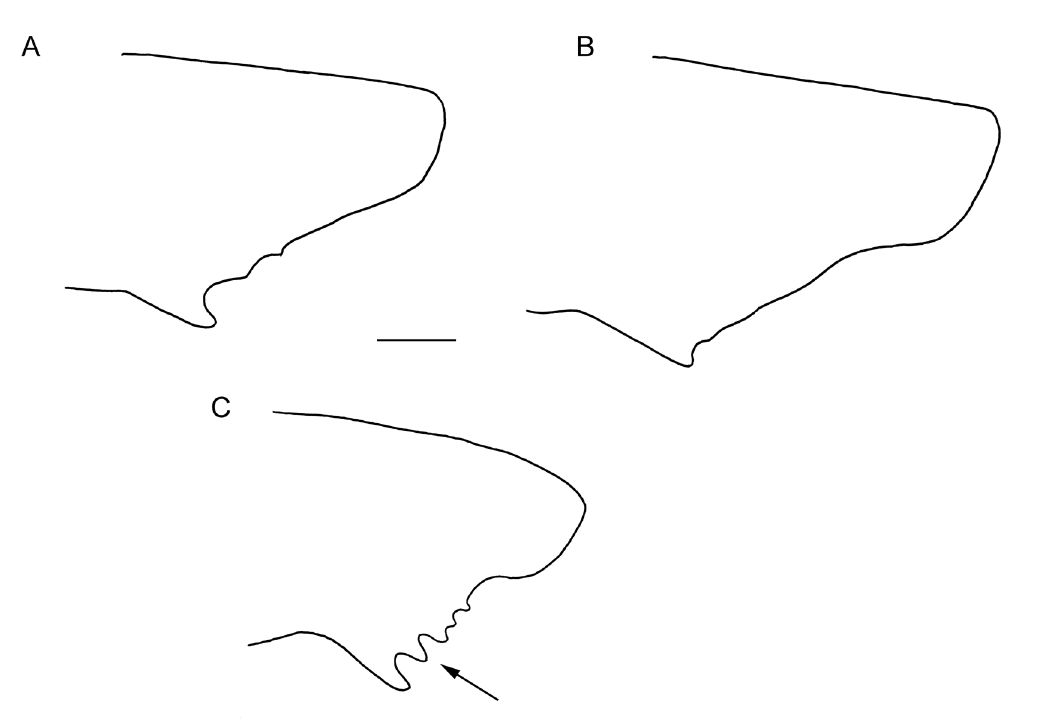
Fig. 23. Apical part of male metafemur, lateral view. A–B . Merodon nasicus Bezzi, 1915. A . Specimen RBINS (FSUNS ID 29176). B . Specimen TAUI (FSUNS ID 04972). C . M. funestus (Fabricius, 1794) (FSUNS; FSUNS ID F98), dentate apicoventral triangular lamina on metafemur marked with arrow. Scale bar = 1